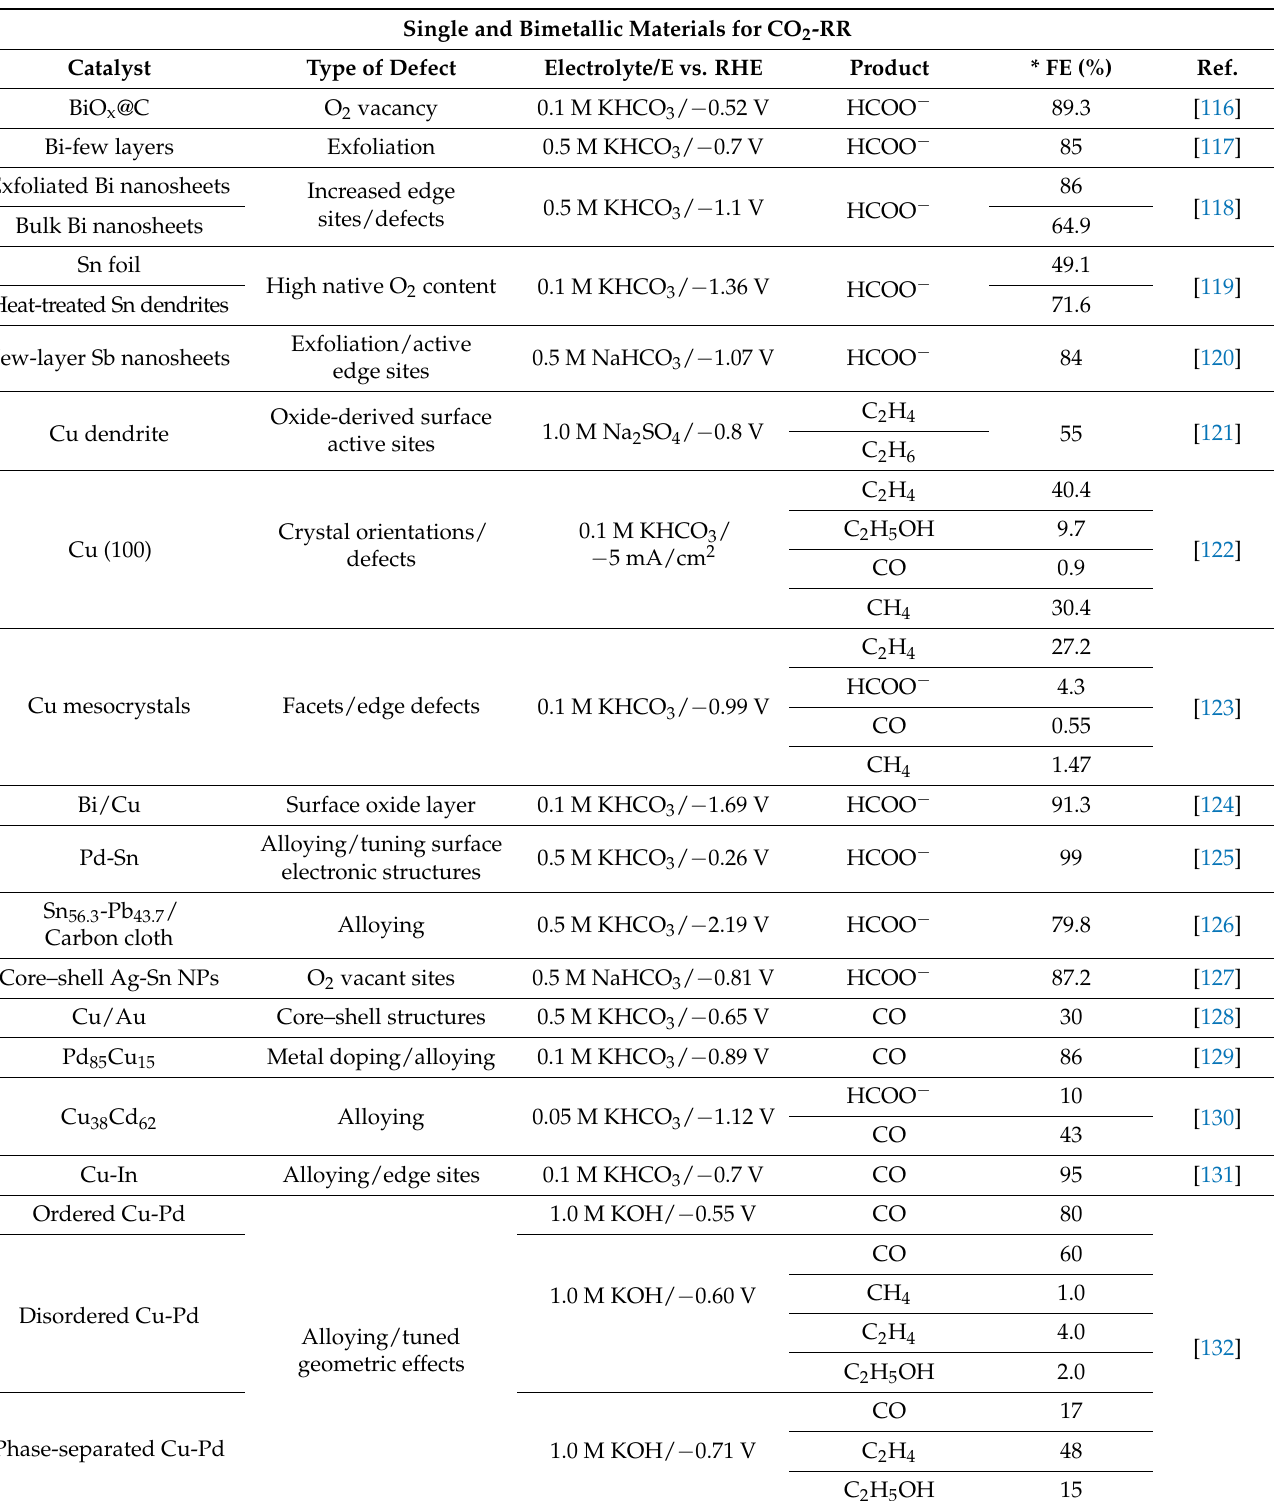
Table 1. Single- and bimetallic-material-based electrocatalysts for electrochemical CO 2 -RR. Single and Bimetallic Materials for CO 2